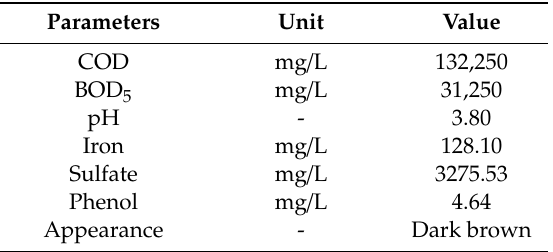
Table 3. Chemical properties of raw